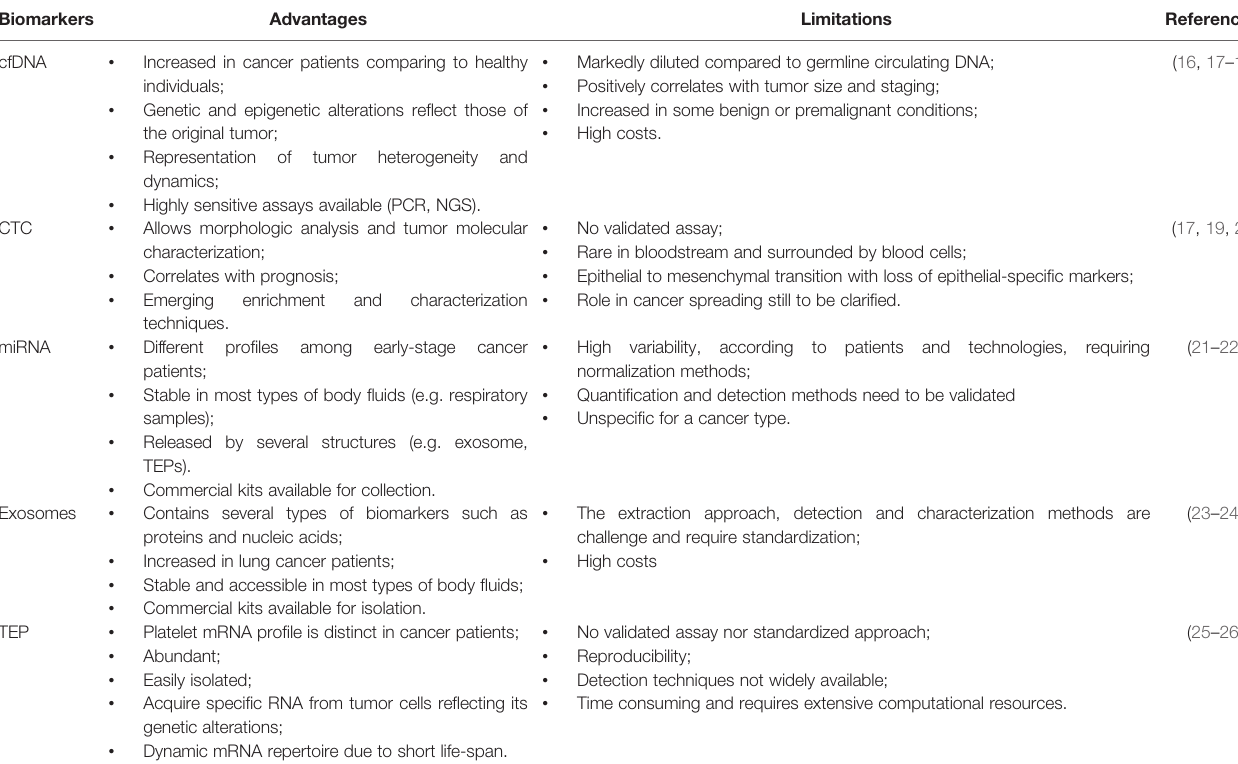
TABLE 1 | Summary of advantages and limitations in LC diagnosis according to liquid biopsy-based biomarker. Biomarkers